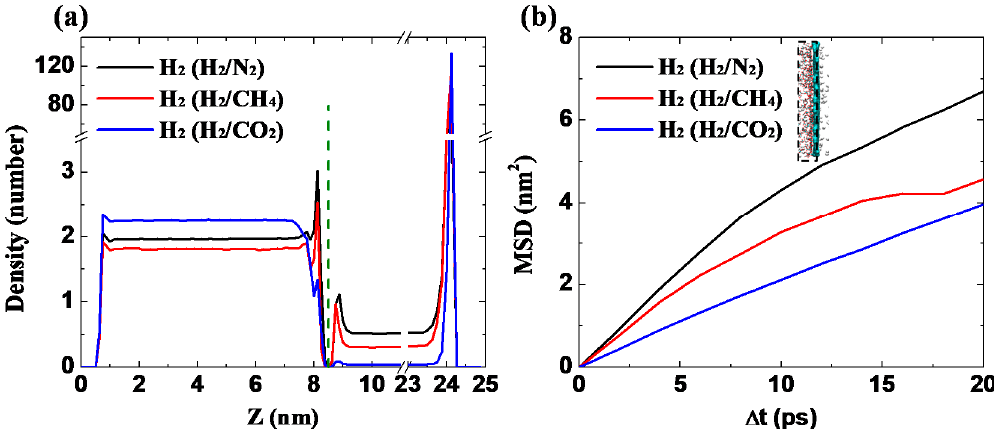
Figure 7. Permeation behavior of H 2 in binary mixtures. ( a ) The number distributions along the z-direction in the last 10 ns. The membrane is located at the green dotted line; ( b ) The mean square displacement (MSD) curves of H 2 crossing the GDY_2.1Å membrane. (Inset) The region within 0.5 nm of the membrane surface for MSD calculation.